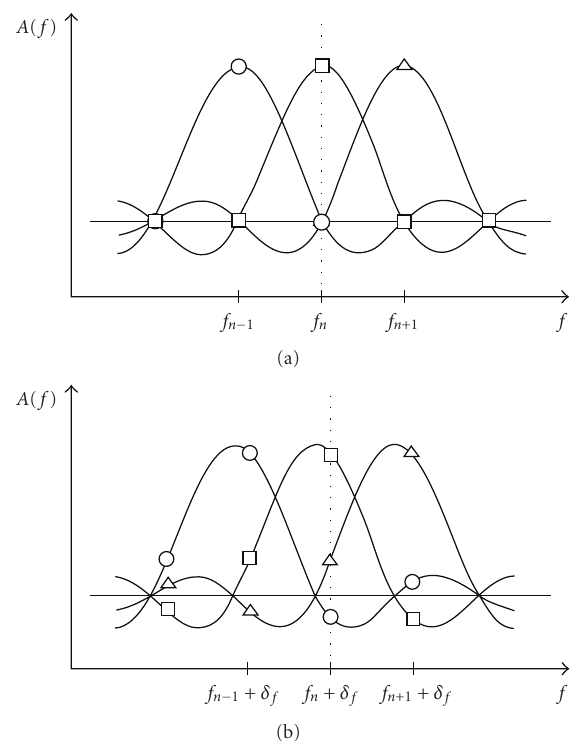
Figure 1: E ff ects of frequency shift on OFDM